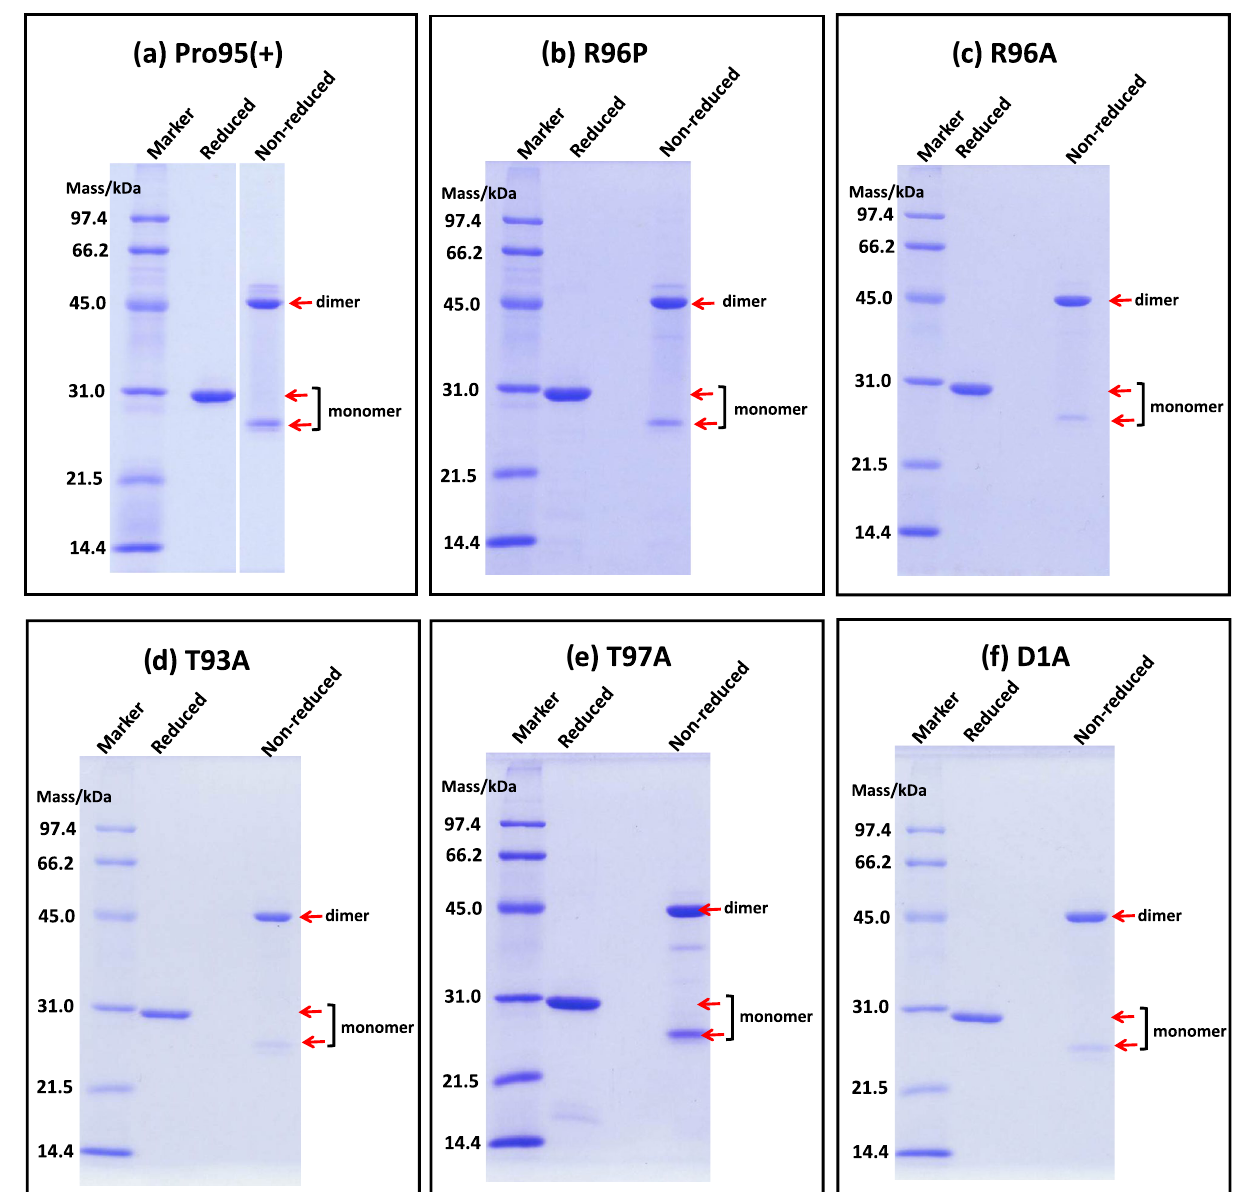
Figure 5. SDS-PAGE for mutants. SDS-PAGE (12% gel) with CBB staining was carried out following the procedure described in Fig. 3a. Each mutant was purified by cation chromatography. A band of dimer at approximately 45 kDa is observed under non-reduced condition. ( a ) Pro95(+); A faint band at ~ 50 kDa is observed over the dimer band at 45 kDa under non-reduced condition. Under the reduced condition, a band is observed at approximately 29 kDa; no other bands are detected. ( b ) R96P; In this sample, a faint band at ~ 50 kDa is observed over the dimer band at 45 kDa under non-reduced condition. Under the reduced condition, a band is observed at approximately 28 kDa; no other bands are detected. ( c ) R96A; Under both reduced and non-reduced conditions, no other bands except R96A mutant are observed. ( d ) T93A; Under both reduced and non-reduced conditions, no other bands except R96A mutant are observed. ( e ) T97A; A faint band at ~ 40 kDa below the dimer band (44 kDa) is detected under the non-reduced condition, whereas the monomer band is clearer compared with that of other mutants. A faint band caused by a small amount of impurities is observed at ~ 16 kDa. ( f ) D1A; under both reduced and non-reduced conditions, no other bands except R96A mutant are